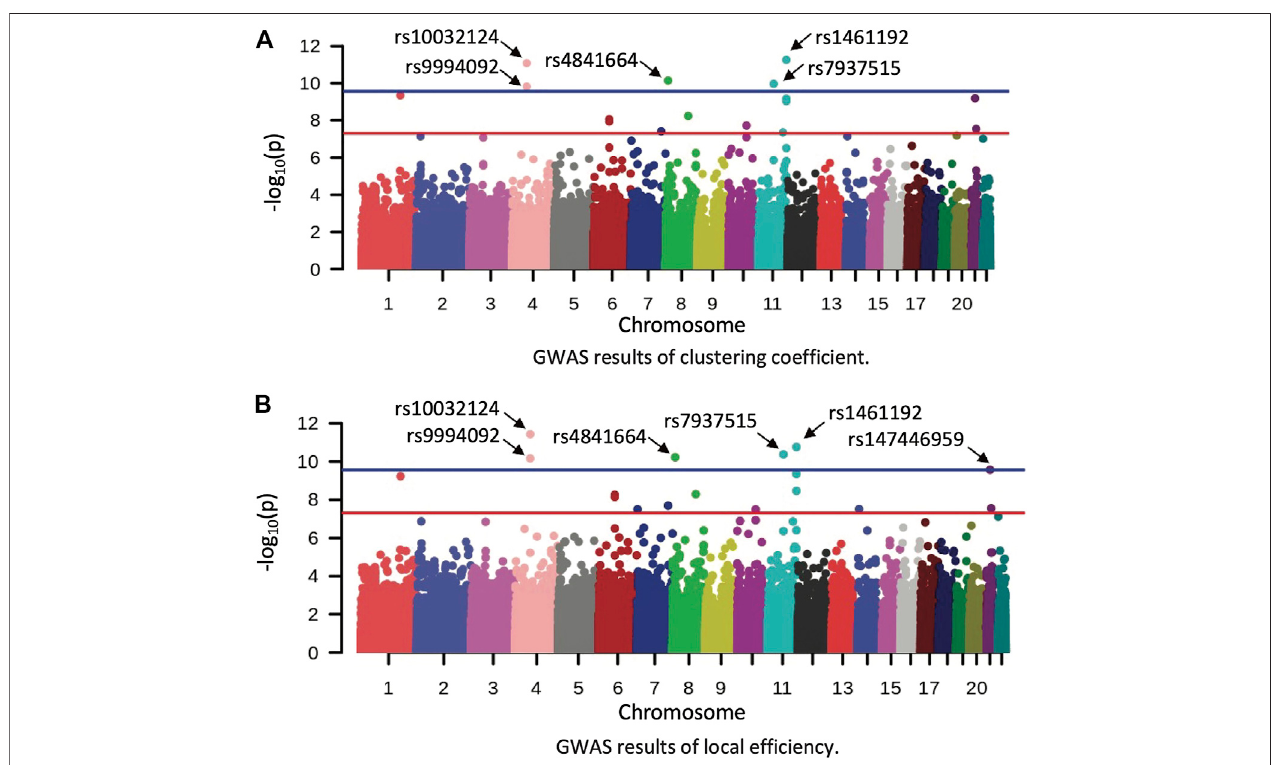
FIGURE 2 | Manhattan plot of GWAS results in the HCP dataset. (A,B) show the GWAS results of clustering coef fi cient and local ef fi ciency on left middle temporal gyrus, respectively. Red and blue lines correspond to the p -value of 5E-08 and 2.75E-10, respectively.